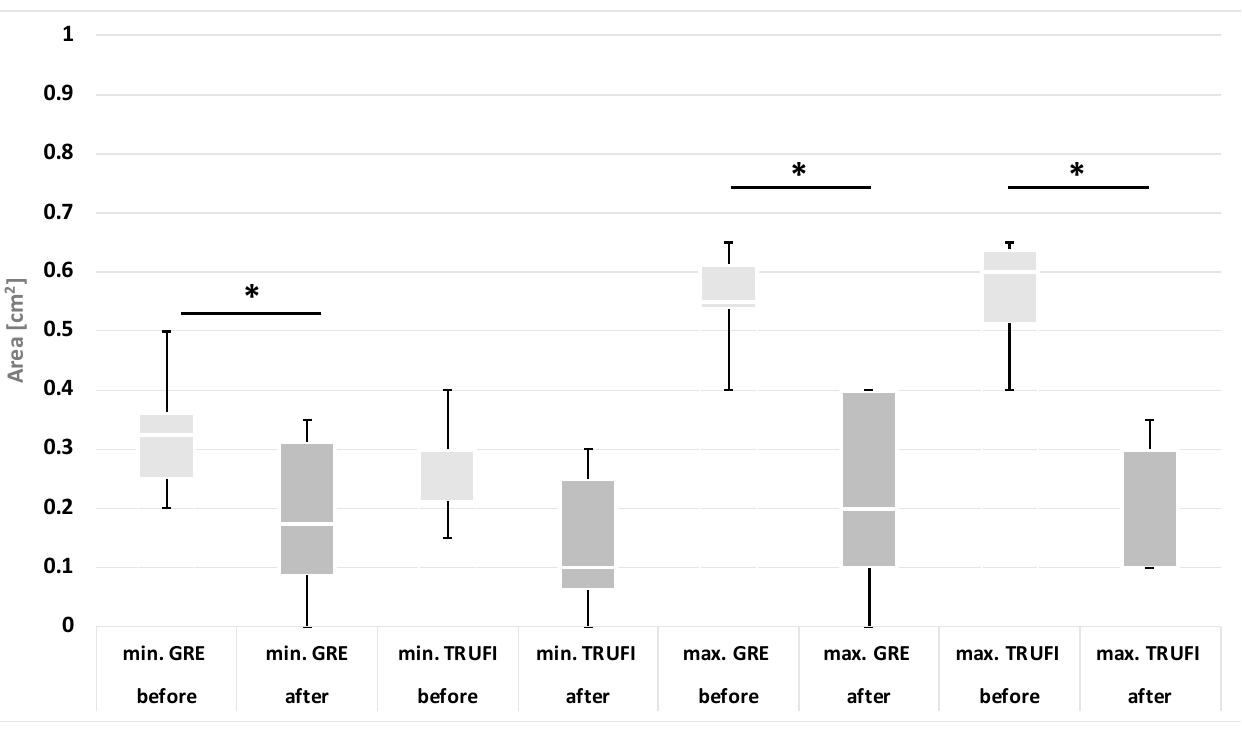
Figure 6. The minimum and maximum values of the area of the rima glottidis compartments obtained with the use of dynamic MRI sequences in the group of patients with paralyzed vocal folds after surgery compared to the preoperative examination results. * p < 0.05.